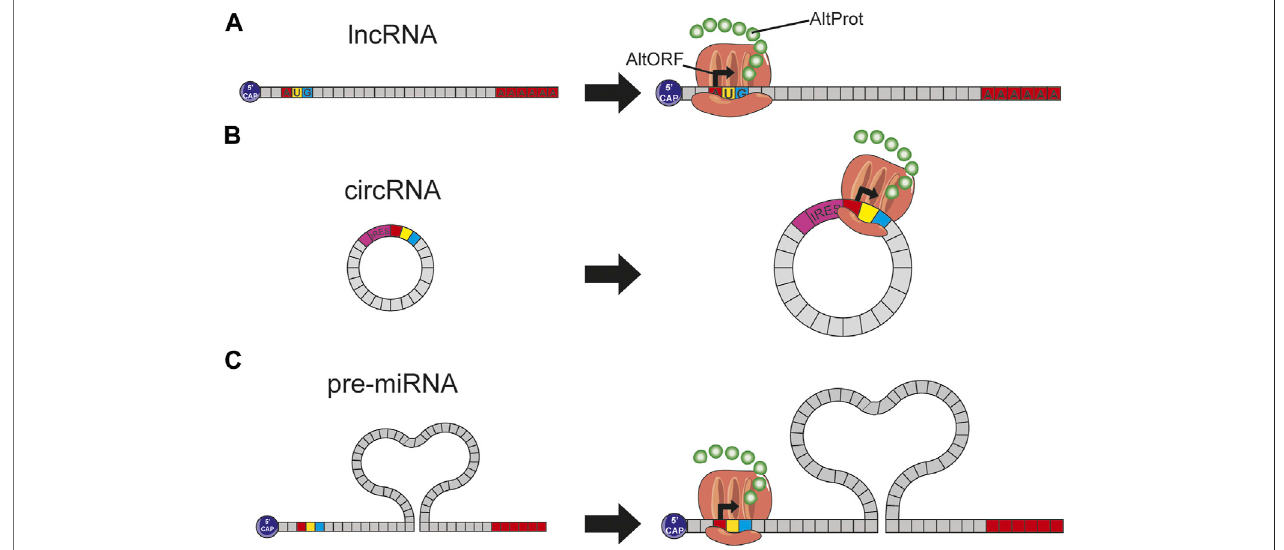
FIGURE 3 | (A) The presence of a start codon on an lncRNA induces this translation into protein by the ribosome; this protein, not predicted in conventional databases, is therefore considered to be AltProt. (B) circRNA arbors an IRES site helping the ribosome fi xation and thus the expression of some proteins. (C) Pre- miRNAs have on their sequence some start codons involving the ribosome binding and thus the transcription of AltProt.